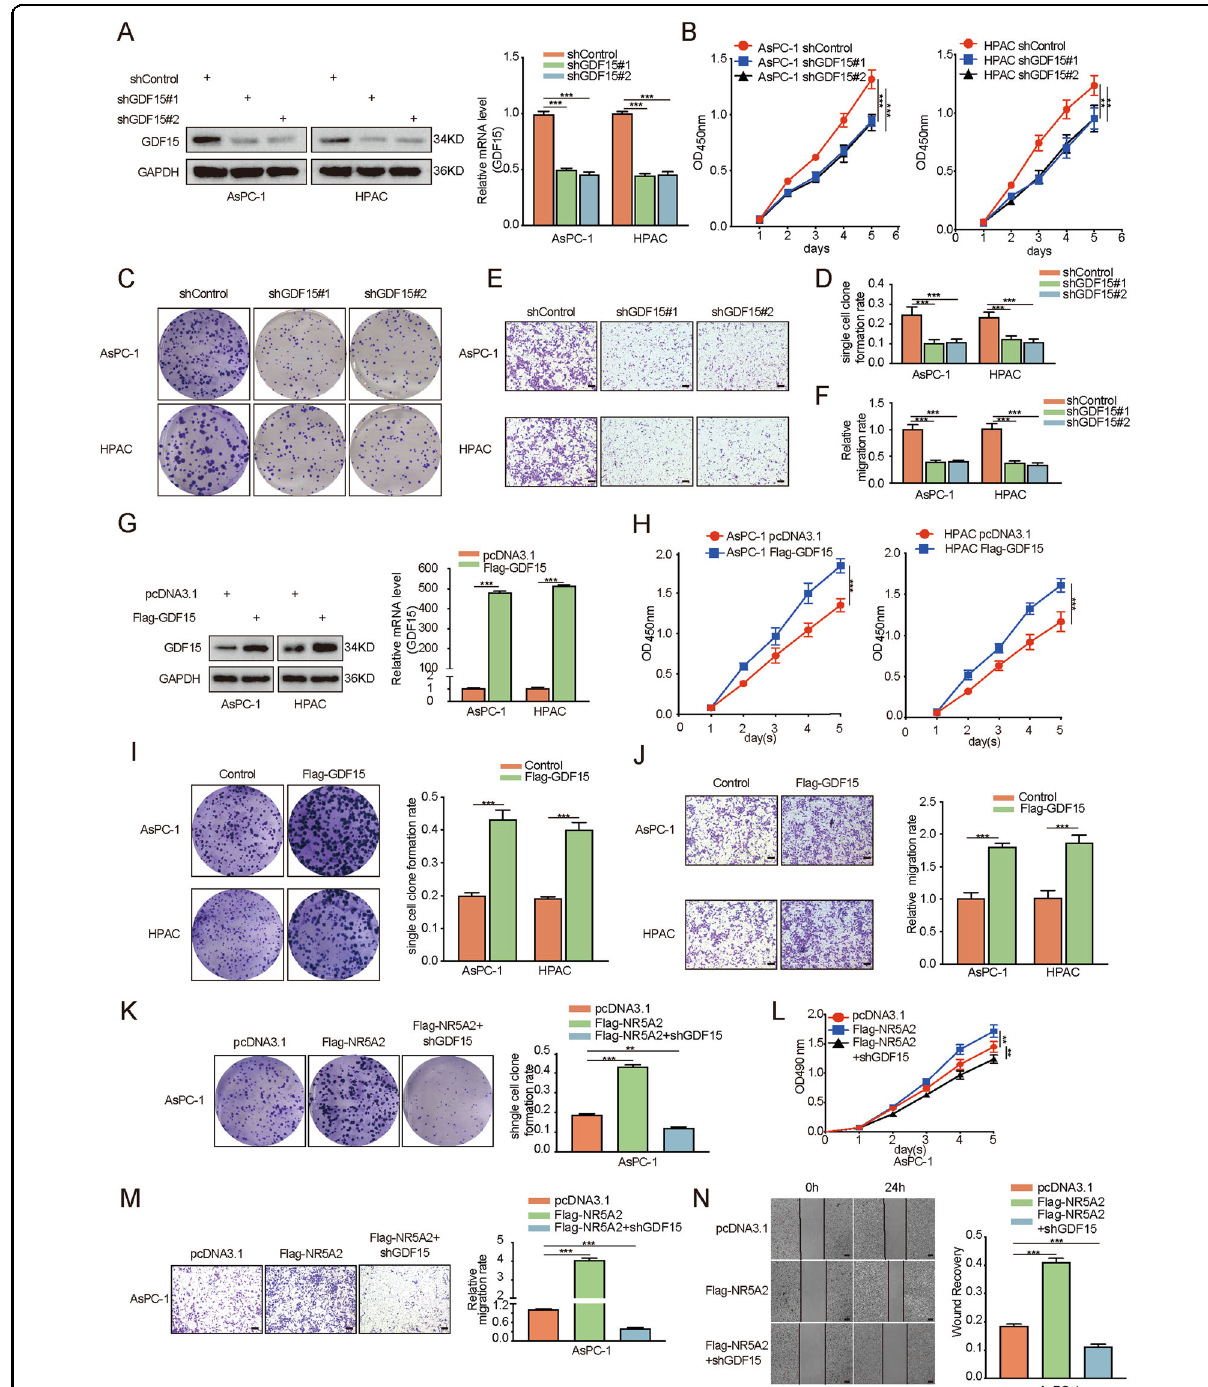
In addition to interacting with acetylated histones, BRD4 also promotes cancer progression by regulating the interaction with transcription factors in cancer cells 24 – 26